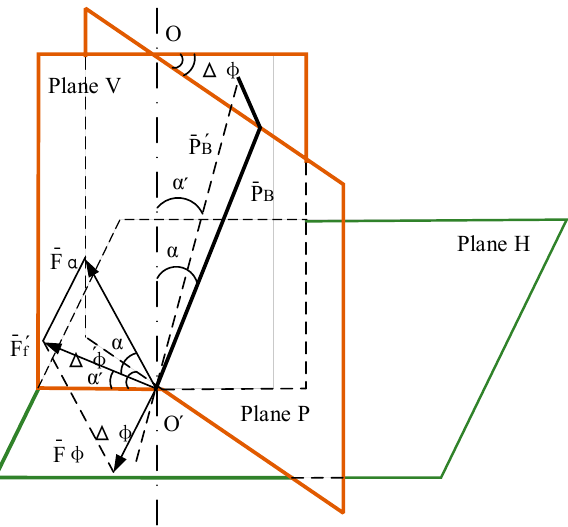
Figure 16. Analysis of formation variable well deviation force F α and formation variable azimuth force F φ Table 1. Symbols and nature relations of F (cid:2961) and F (cid:2990) .